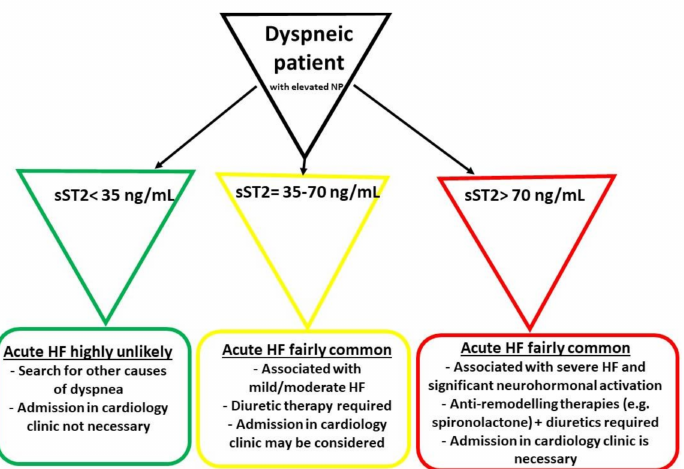
Figure 1. The initial management of patients presenting in emergency room with dyspnea and elevated natriuretic peptides (NP) (adapted from Aleksova et al.) [65]. HF—heart